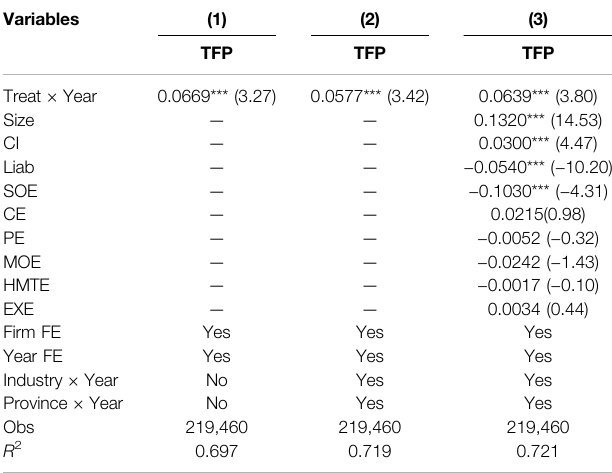
TABLE 4 | The impact of the environmental target responsibility system on TFP of fi rms.